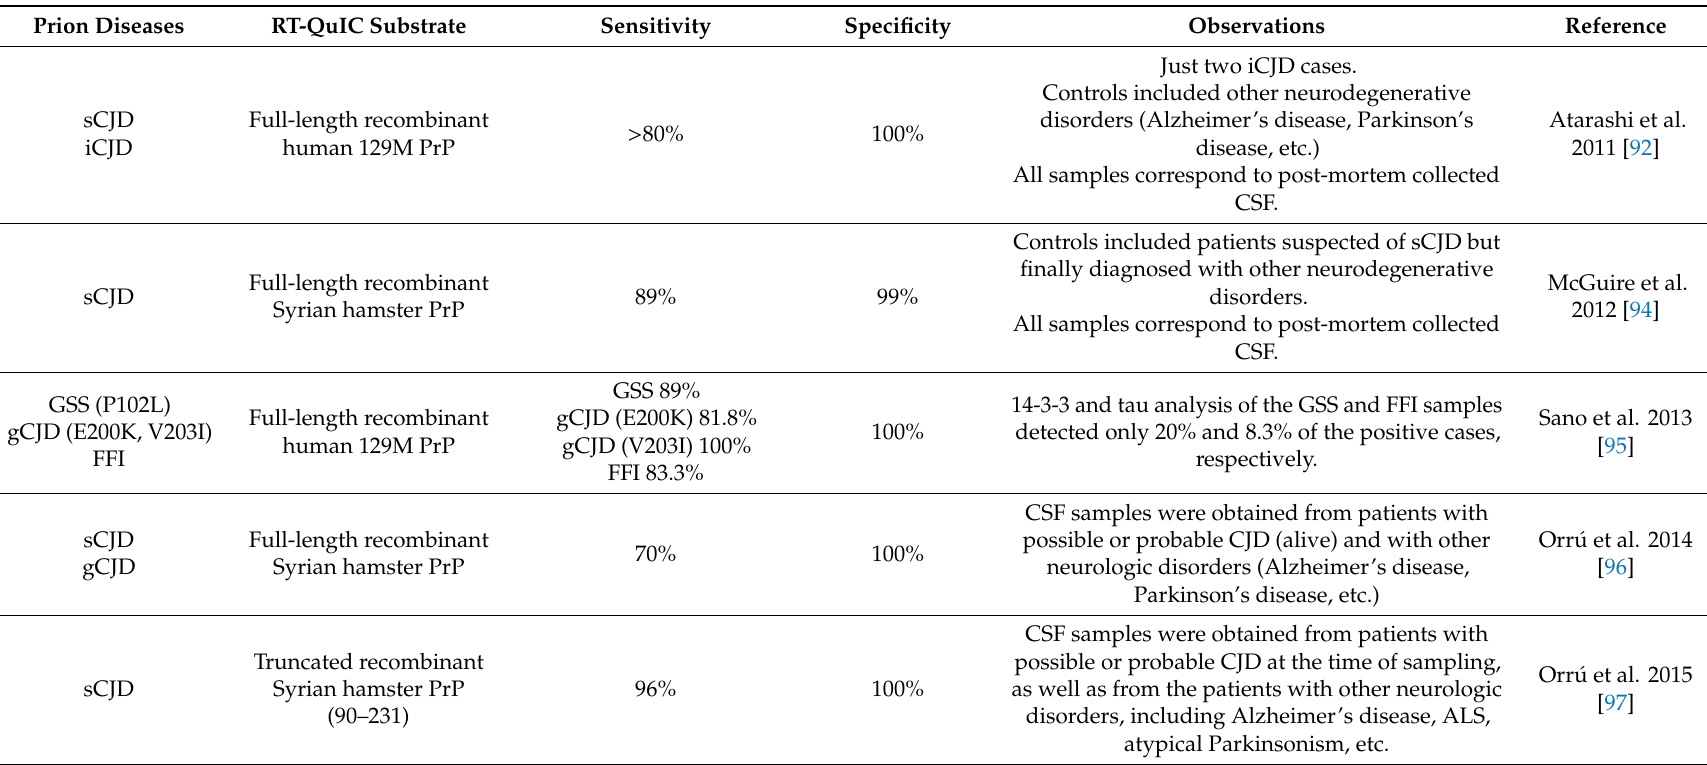
Table 1. List of studies performed using Real Time-Quaking Induced Conversion (RT-QuIC) in cerebrospinal fluid (CSF) from patients a ff ected by di ff erent prion diseases. A summary of the most relevant parameters such as RT-QuIC substrate, assay sensitivity, and specificity are included. Creutzfeldt-Jakob disease (CJD), Sporadic Creutzfeldt-Jakob disease (sCJD), iatrogenic Creutzfeldt-Jakob disease (iCJD), prion protein (PrP), cerebrospinal fluid (CSF), Gerstmann-Sträussler-Scheinker syndrome (GSS), genetic Creutzfeldt-Jakob disease (gCJD), Familial Fatal Insomnia (FFI), Amyotrophic Lateral Sclerosis (ALS), Variably protease-sensitive prionopathy